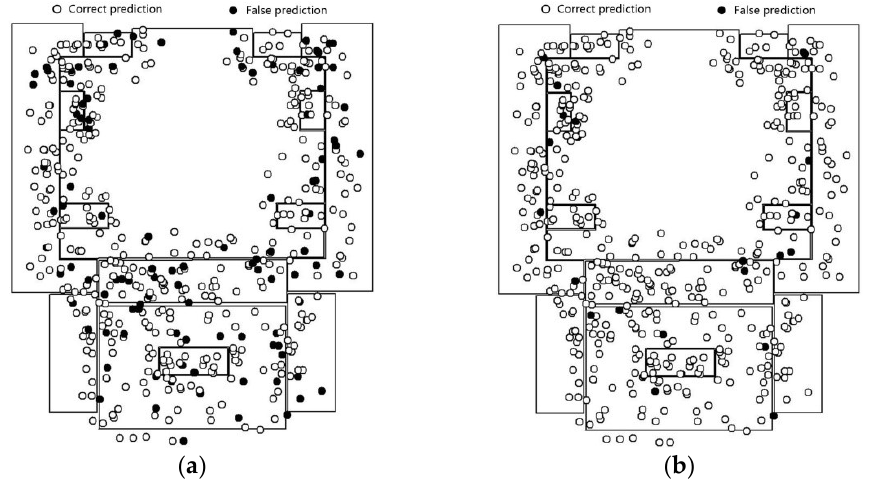
Figure 13. Prediction result for the railway station scenario. ( a ) Inception V3; ( b ) the feature fusion model.